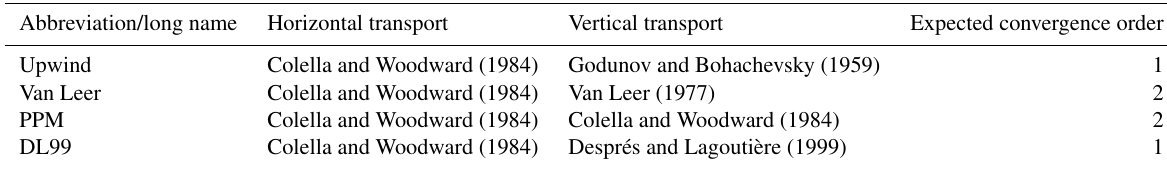
Table 1. Summary of the different transport configurations that have been tested.